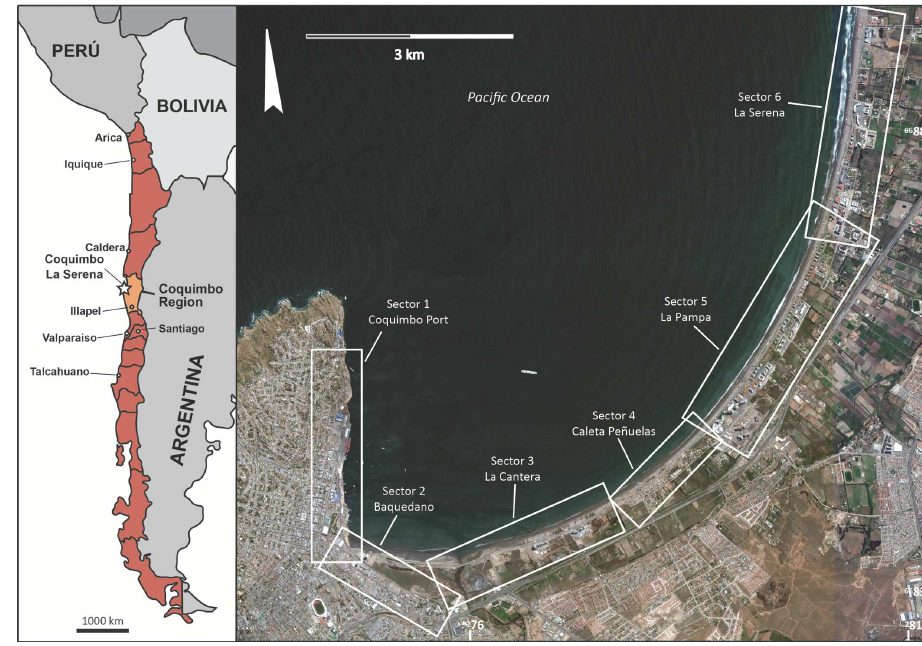
Figure 1. Location of the study area and the analyzed sectors in the Coquimbo Bay (image courtesy of Google Earth).